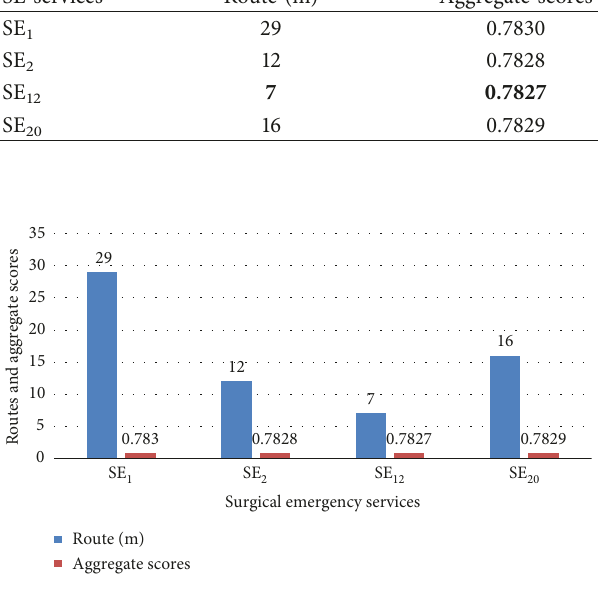
Figure 2: Shortest route service selection in critical situations.